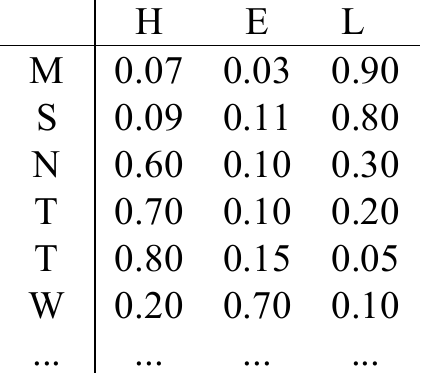
! Figure 2. A structural profile matrix for protein secondary structure